Question: Which kind of chart has been used to present this data?
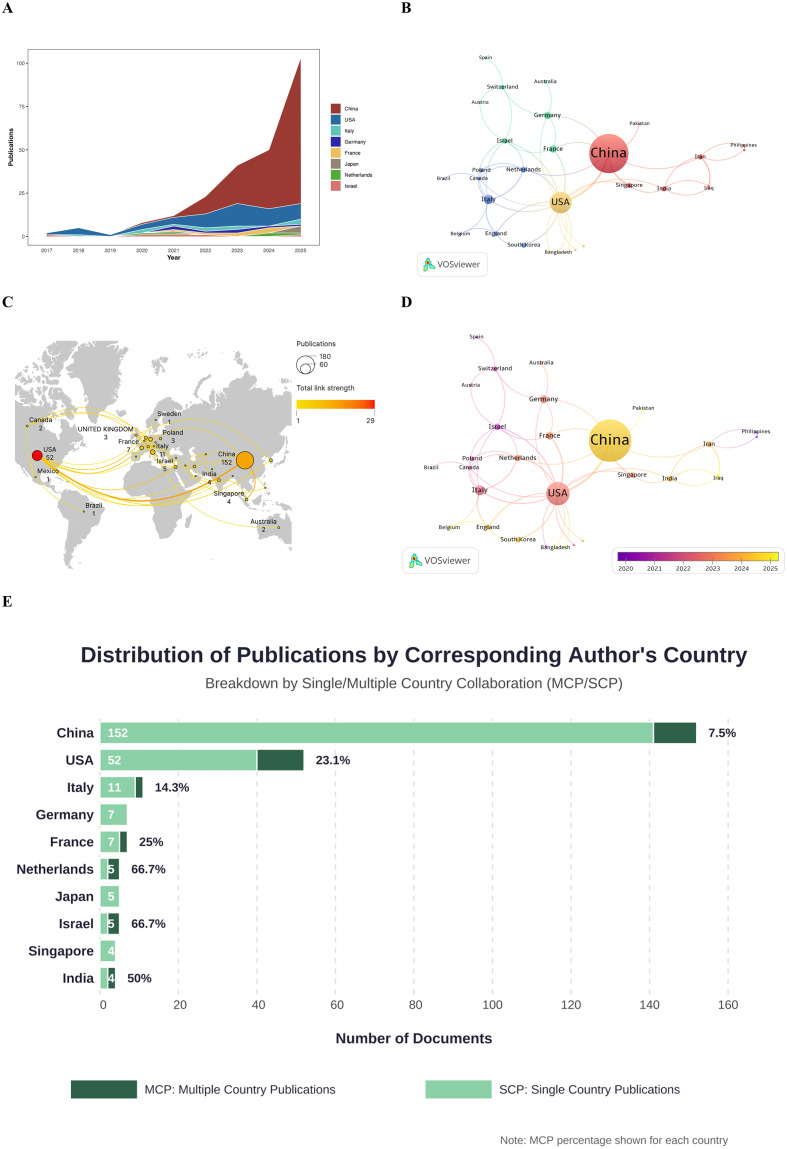
Answer: line